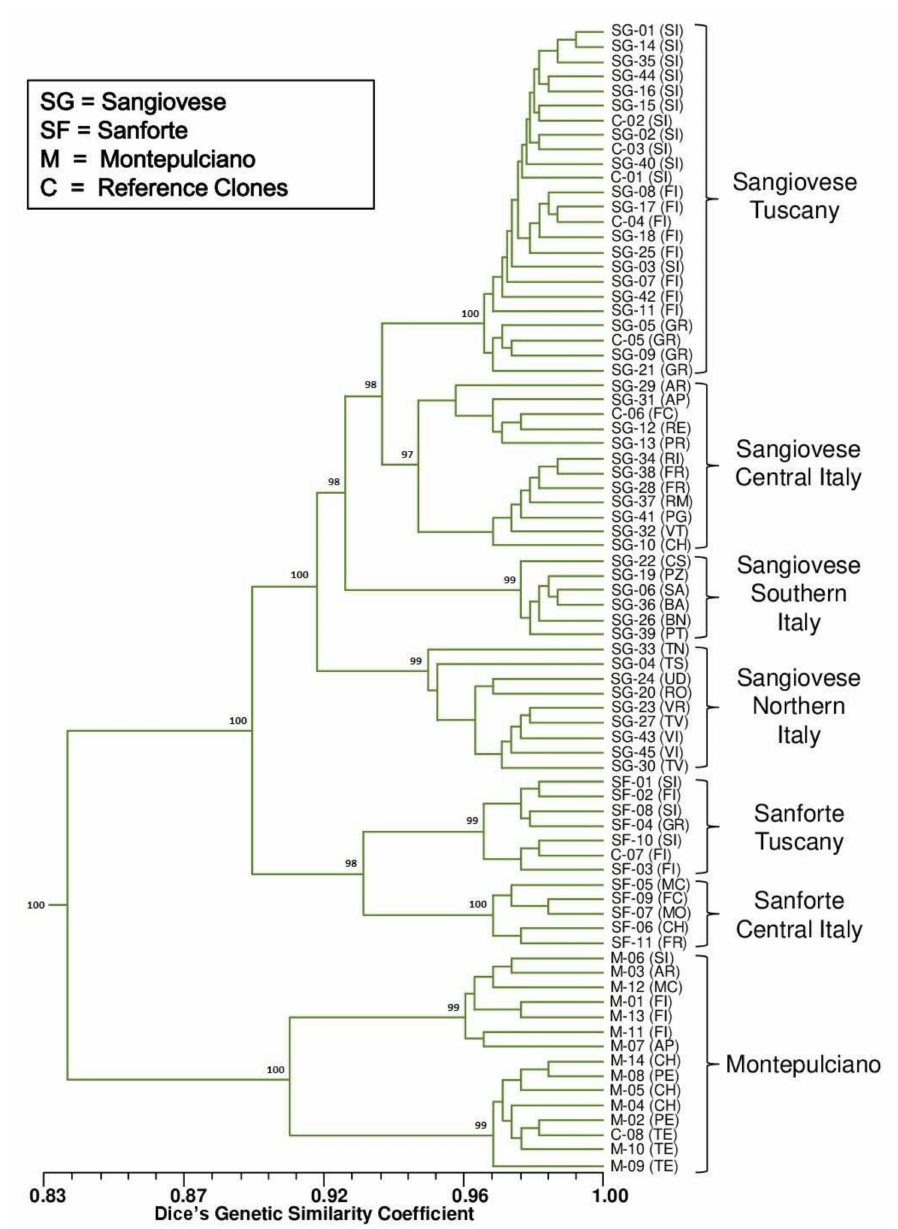
Figure 3. UPGMA dendrogram based on genetic diversity of the 78 samples of Sangiovese, Sanforte, and Montepulciano based on AFLP, SAMPL, M-AFLP, and I-SSR molecular markers. For sample cor- respondences, see Table 3—Assigned codes). Bootstrap values are indicated. Cophenetic correlation coefficient =